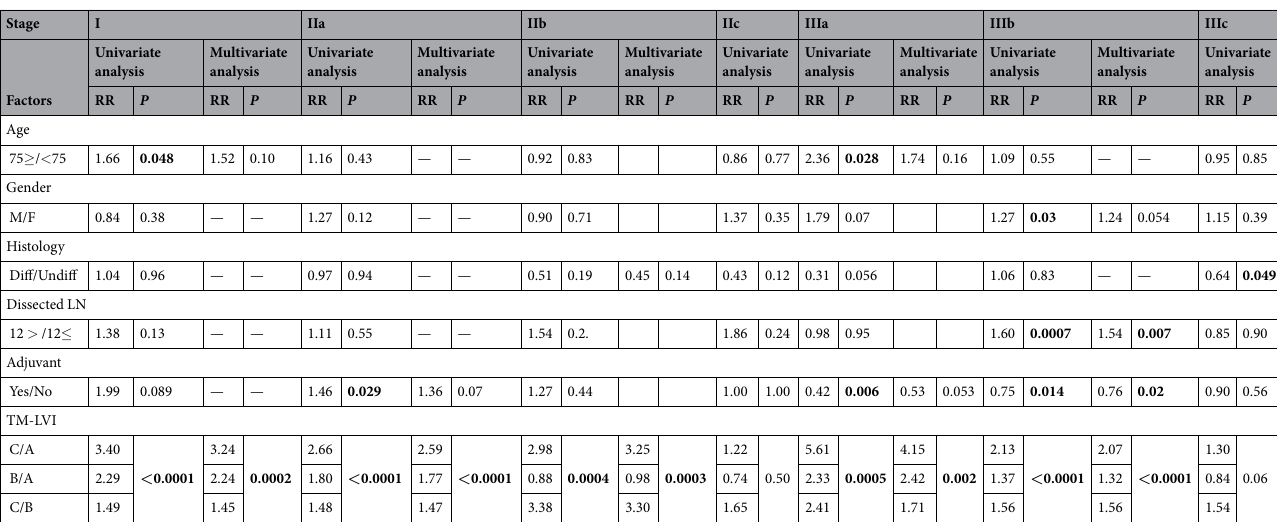
Table 3. Univariate and multivariate analysis for relapse-free survival of rectal cancer was performed in each clinical stage. TM-LVI was an independent prognostic factor for relapse-free survival of rectal cancer in stage I, IIa, IIb, IIIa, and IIIb. M/F, Male/Female; Diff/Undiff, Differentiated/Undifferentiated; LN, Lymph node; RR, Risk ratio; Bold type, P <